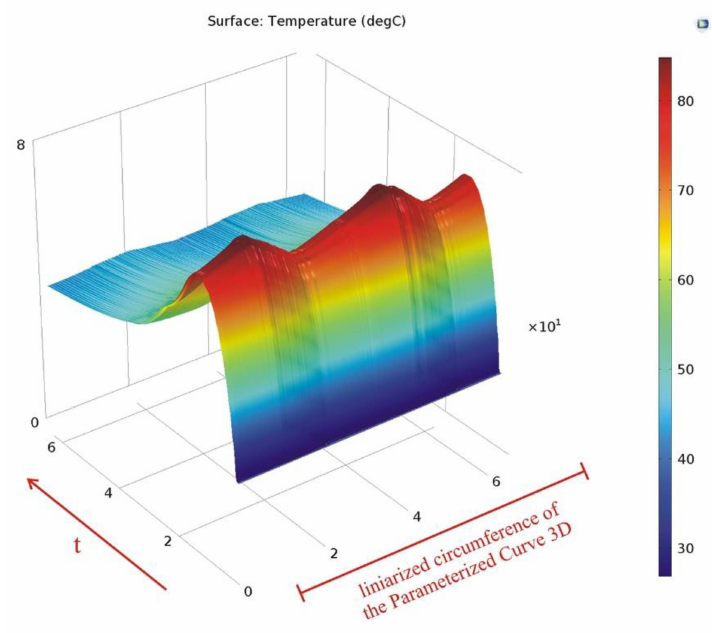
Figure 11. Temperature variation in time along the parameterized